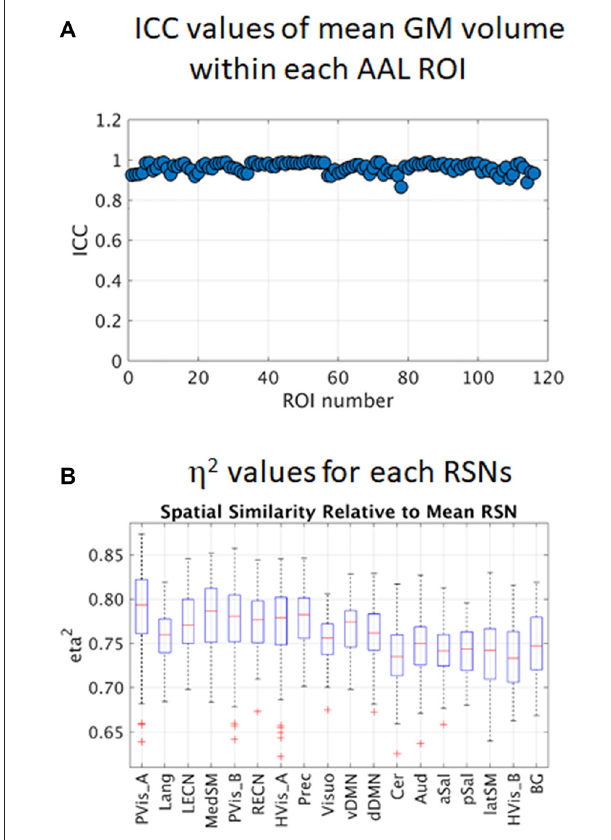
FIGURE 3 | Intra-class correlation (ICC) values of regional gray matter (GM) volume within 116 AAL regions of interest (ROIs; A ) and estimated η 2 values of the 18 resting state networks (RSNs; B ). PVis_A, primary visual (anterior); Lang, language; LECN, left executive control; MedSM, sensorimotor (medial); PVis_B, primary visual (medial); RECN, right executive control; HVis_A, high visual (medial); Prec, precuneus; Visuo, visuospatial; vDMN, ventral default mode; dDMN, dorsal default mode; Cer, cerebellum; Aud, auditory; aSal, anterior salience; pSal, posterior salience; latSM, sensorimotor (lateral); HVis_B, high visual (lateral); BG, basal